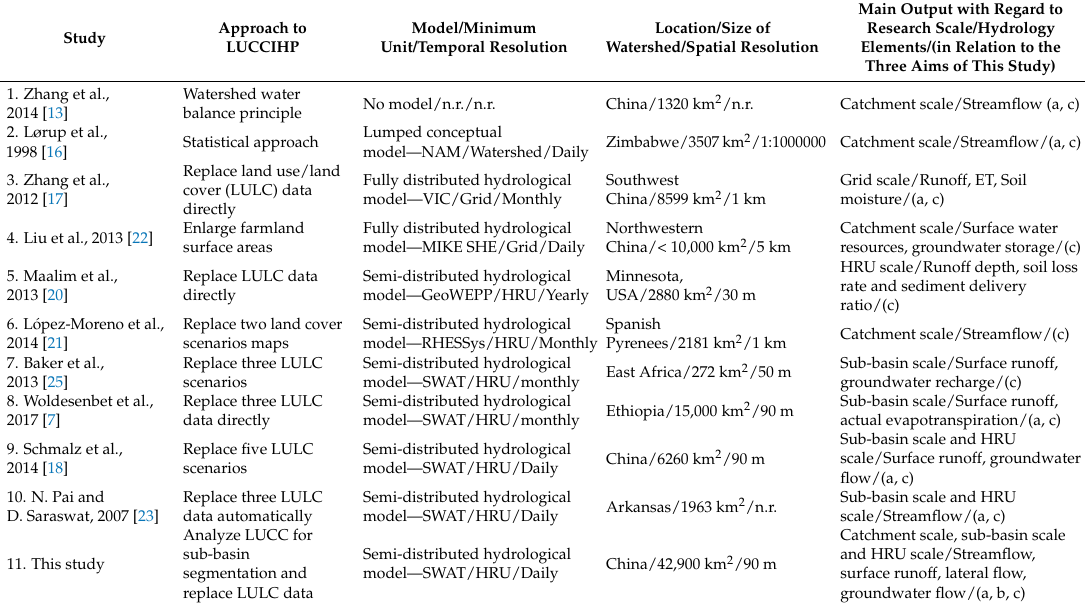
Table 1. Summary of relevant literature indicating LUCCIHP studies based on the watershed water balance principle, statistical approach and distributed hydrological modeling methods in relation to the aims of this study. We added the current study for completeness. The symbol “n.r.” means “not